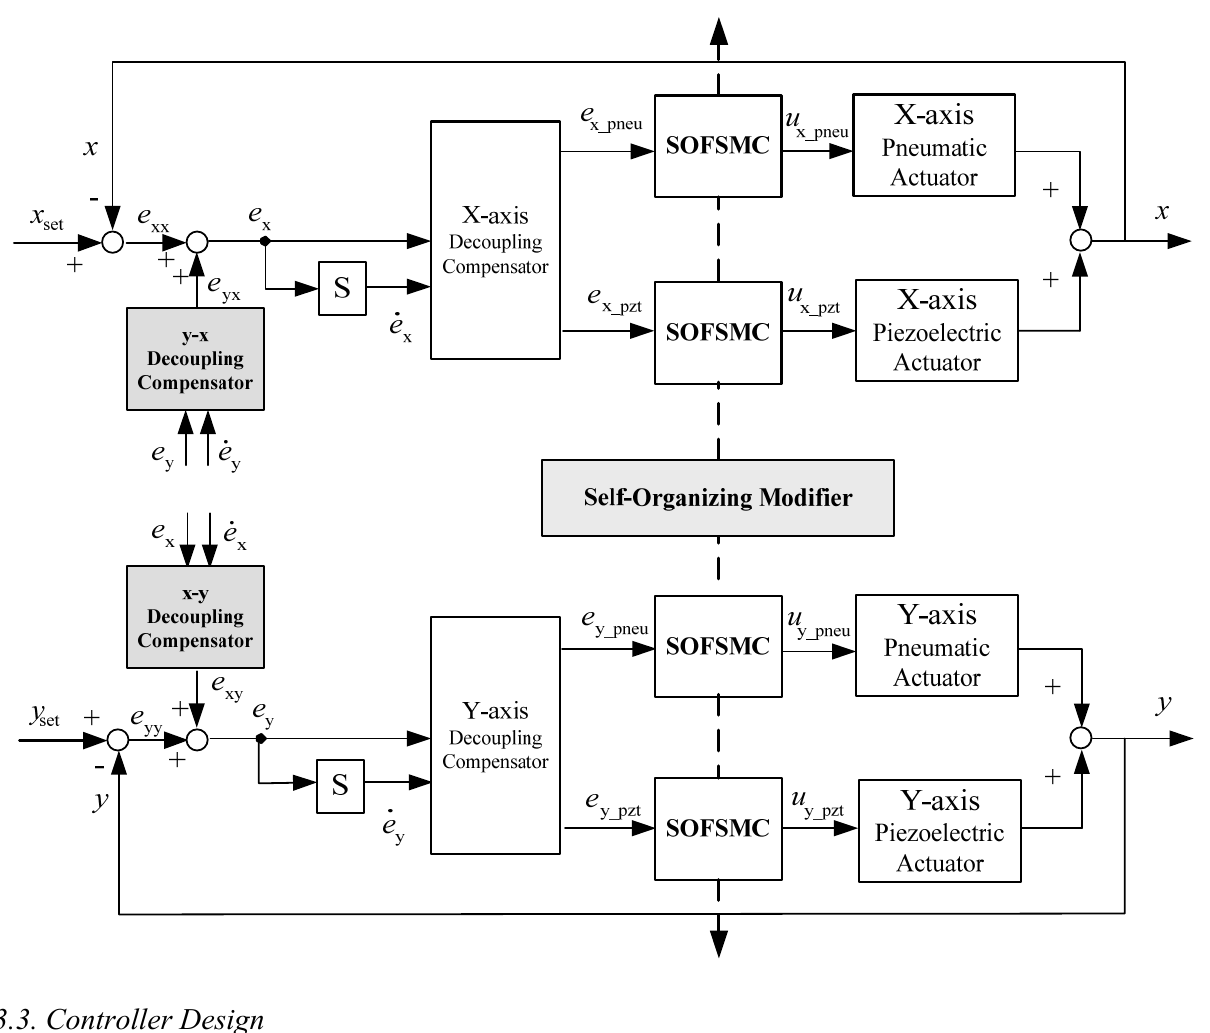
Figure 5. Block diagram of the overall X-Y pneumatic-piezoelectric hybrid positioning